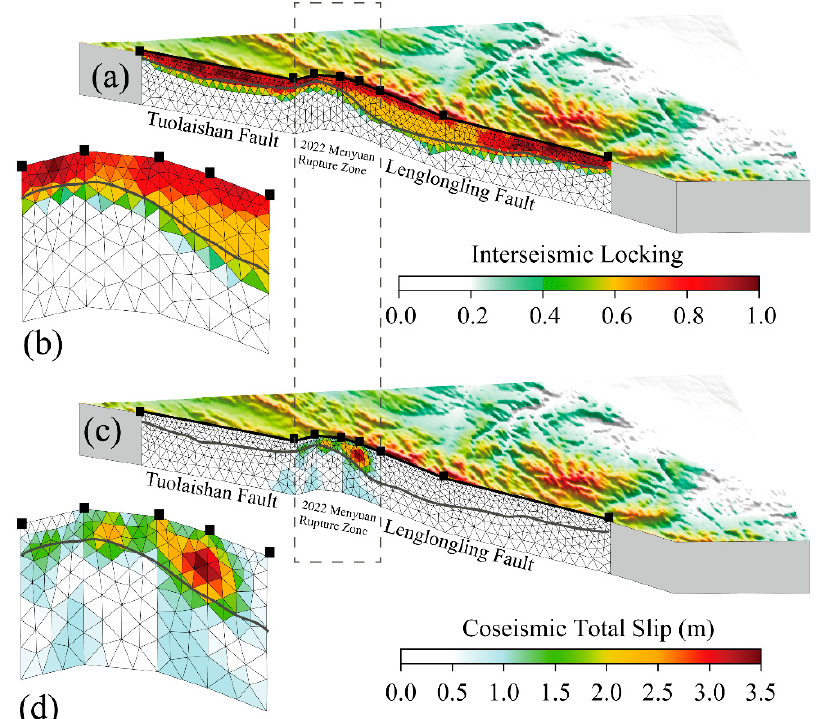
Figure 10. Coseismic slip distribution and fault locking. ( a ) Interseismic locking and ( b ) the locking state of the epicentral region of the 2022 Menyuan earthquake. ( c ) Coseismic slip distribution of the 2022 Menyuan earthquake and ( d ) in the epicentral region. Black curves represent the 0.6 isoline of fault locking while the dotted rectangle indicates the rupture area of the earthquake.